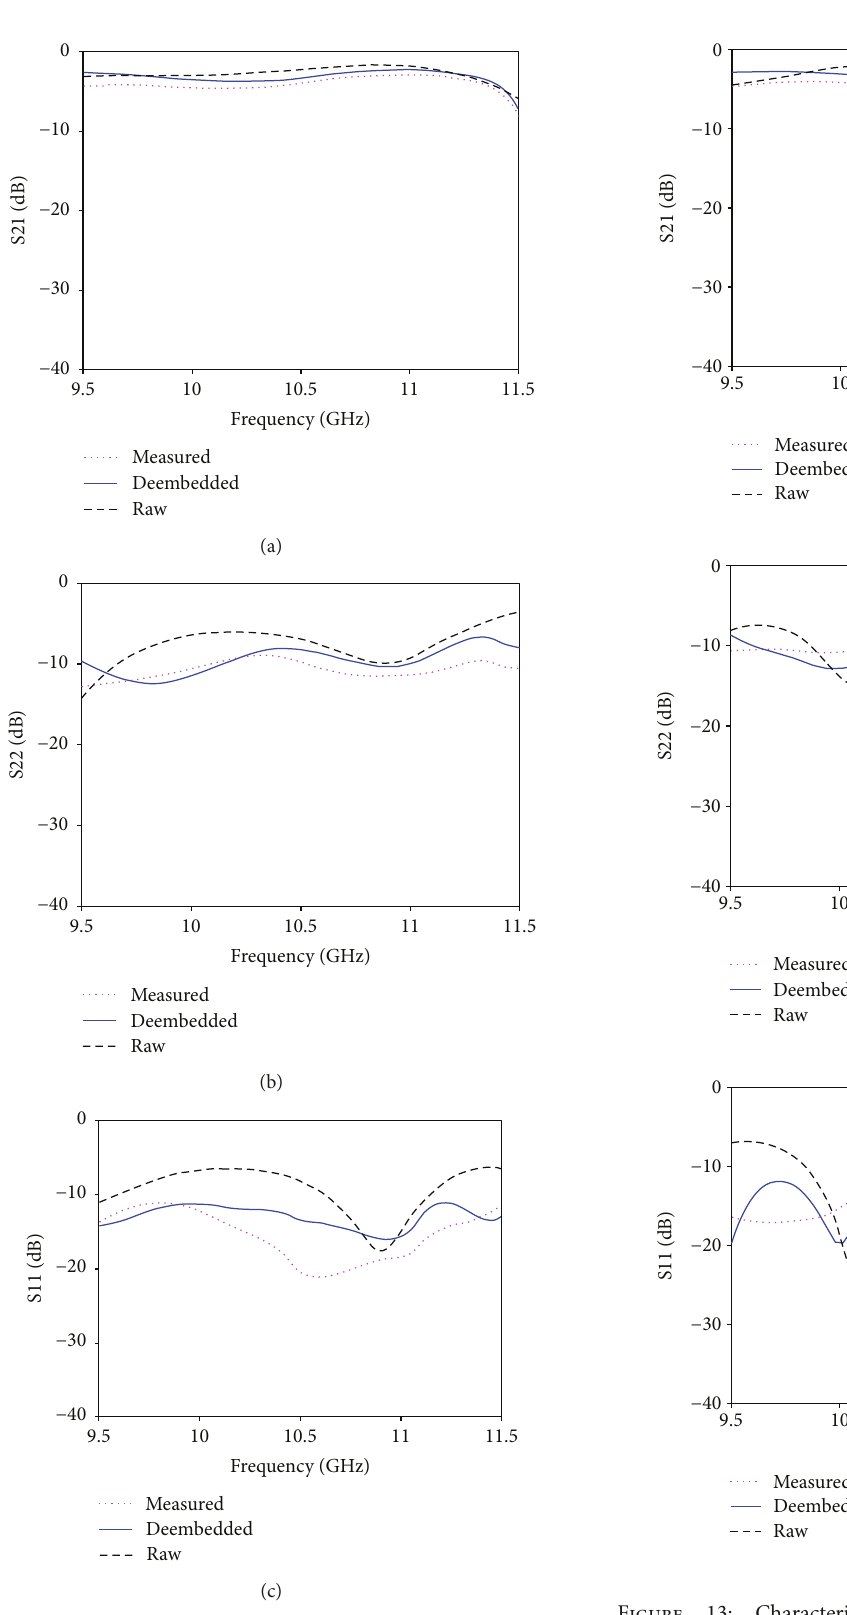
Figure 12: Characteristic S-parameters before and after deembedding of EBG guide with 3 rows and 4 periods. Raw is the simulated result of DUT. (a) S21, (b) S22, and (c) S11.